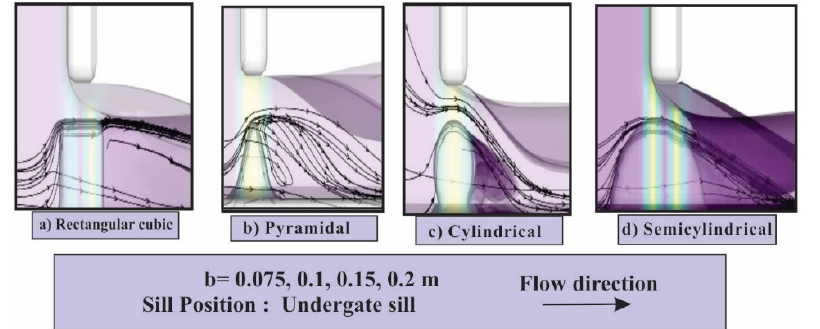
Figure 9. Schematic view of sill geometries.